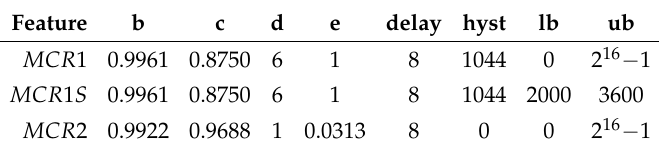
Table 2. Parameters of MCR implementations.